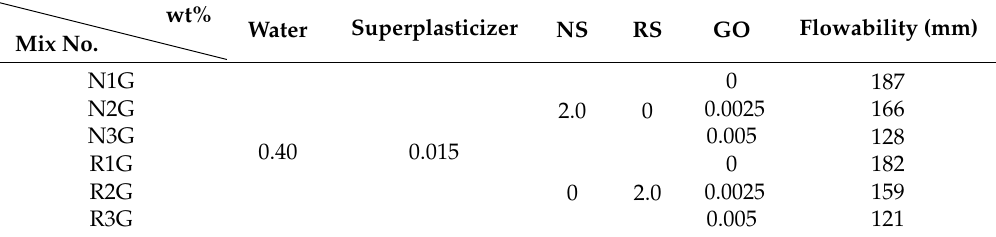
Table 5. Mix design and testing workability of GO-modified mortar associated with NS or RS (assuming the cement content is 1).